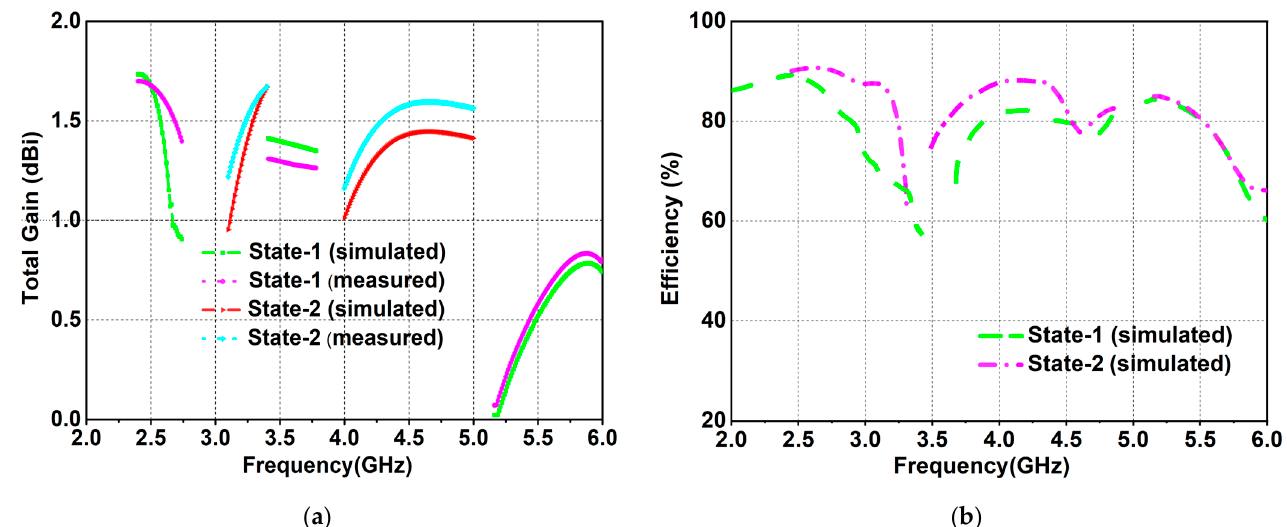
Figure 11. ( a ) The gain plot of the MIMO antenna; ( b ) Efficiency of the MIMO